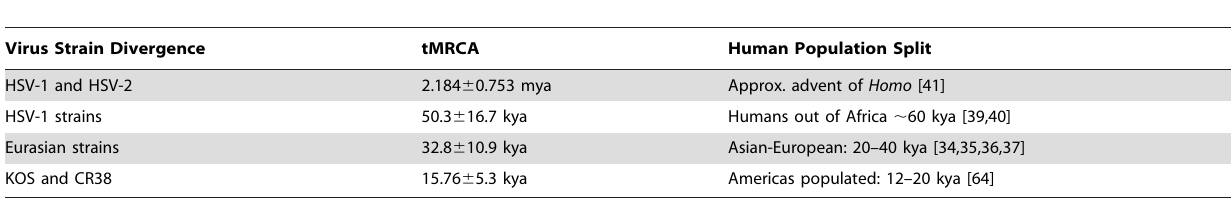
Table 2. Estimates of viral population divergence dates with respect to human populations